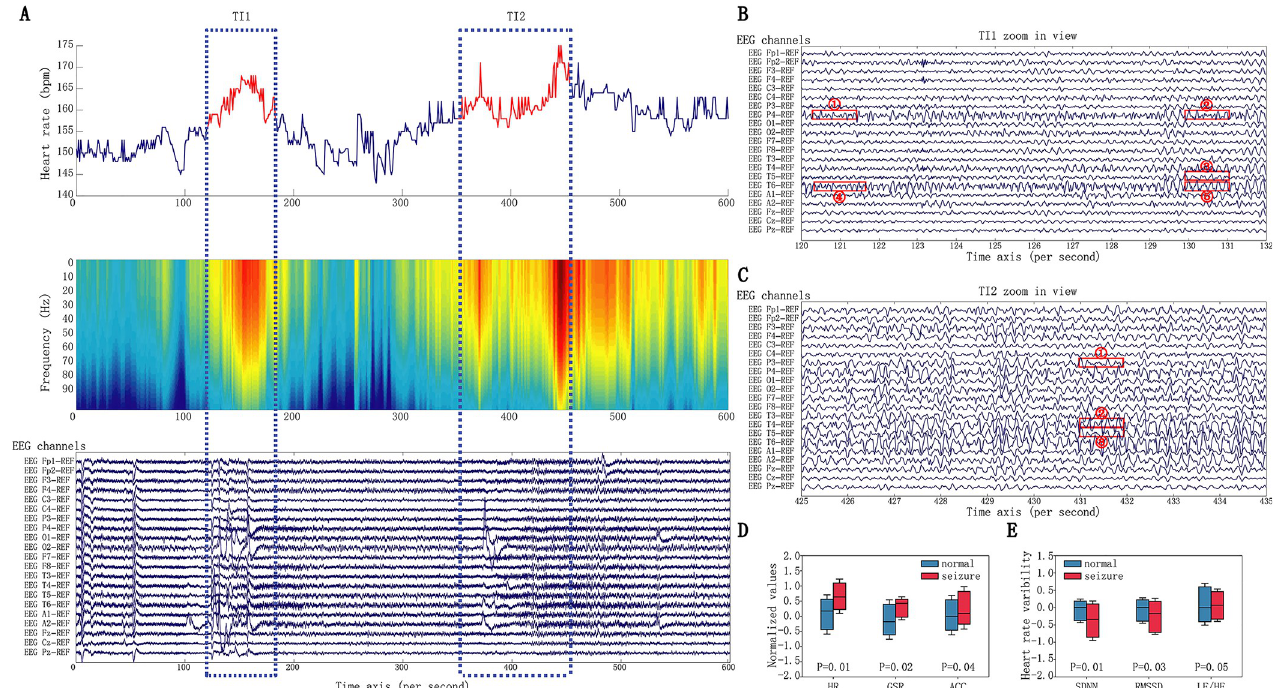
Fig 4. Physiological dynamics associated with seizure events. ( A ). Top panel: Heart rate measurements from a patient in a period of 600 seconds. The measurements during a short time seizure are marked in red, while the signals in the normal periods are marked in blue. Middle panel: The time series measurements were converted by STFT to frequency domain. Bottom panel: EEG signals in the same period are shown in 21 channels. ( B ) Zoomed in view of EEG signal in time interval 1 (TL1). ( C ) Zoomed in view of EEG signal in time interval 2 (TL2). ( D ) The measurement of HR, GSR, ACC during seizure significantly deviated from normal periods. ( E ). The measurement of SDNN, rMSSD, HF/LF during seizure significantly deviated from normal periods.